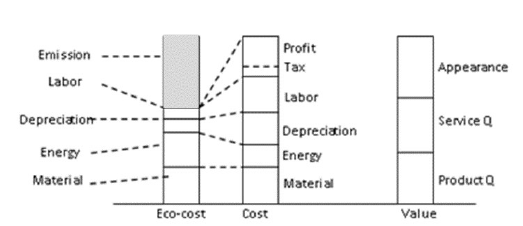
Fig. 1. Eco-Cost Concept